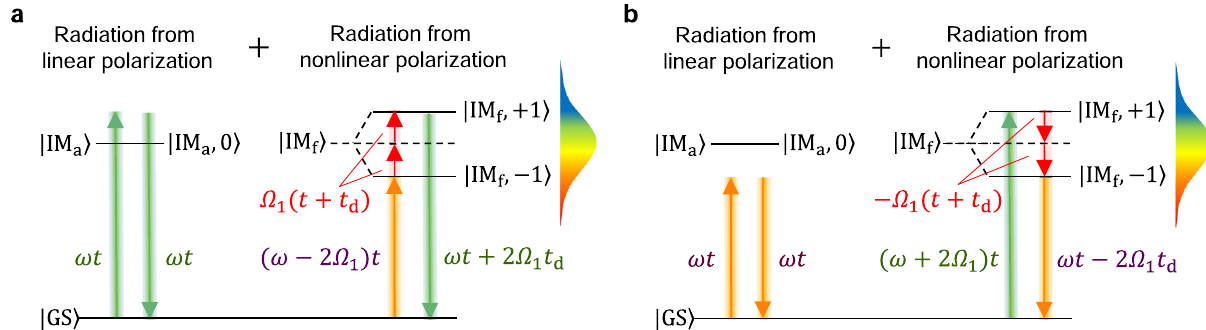
Fig. 4 Schematics of generation mechanism of high-frequency oscillations in re fl ectivity changes. a The case that only the mode 1 of the frequency of Ω 1 is excited by the mid-infrared pulse, and the state |IM f , + 1 〉 is resonantly excited by the combination of three processes indicated by the arrows. The probe pulse covers the energies of the states |IM a 〉 , |IM f , + 1 〉 , and |IM f , − 1 〉 . The linear absorption spectrum is broad and therefore the state |IM a 〉 is also excited. The radiation from the linear polarization of |IM a 〉 and that from the nonlinear polarization of |IM f , + 1 〉 have the phase of ω t and ð ω t þ 2 Ω 1 t d Þ , respectively. t is the delay time of the probe pulse relative to the pump pulse. Those two radiations interfere with each other, giving rise to the oscillation of the d frequency 2 Ω 1 in the pump-probe signal. Phase part of each excitation and radiation is shown by colored characters. b The case that the state |IM f , + 1 〉 is resonantly excited by the probe pulse. The radiation from the linear polarization of |IM a 〉 and that from the nonlinear polarization of |IM f , – 1 〉 have the phase of ω t and ð ω t (cid:2) 2 Ω 1 t d Þ and interfere with each other, giving rise to the oscillation of the frequency 2 Ω